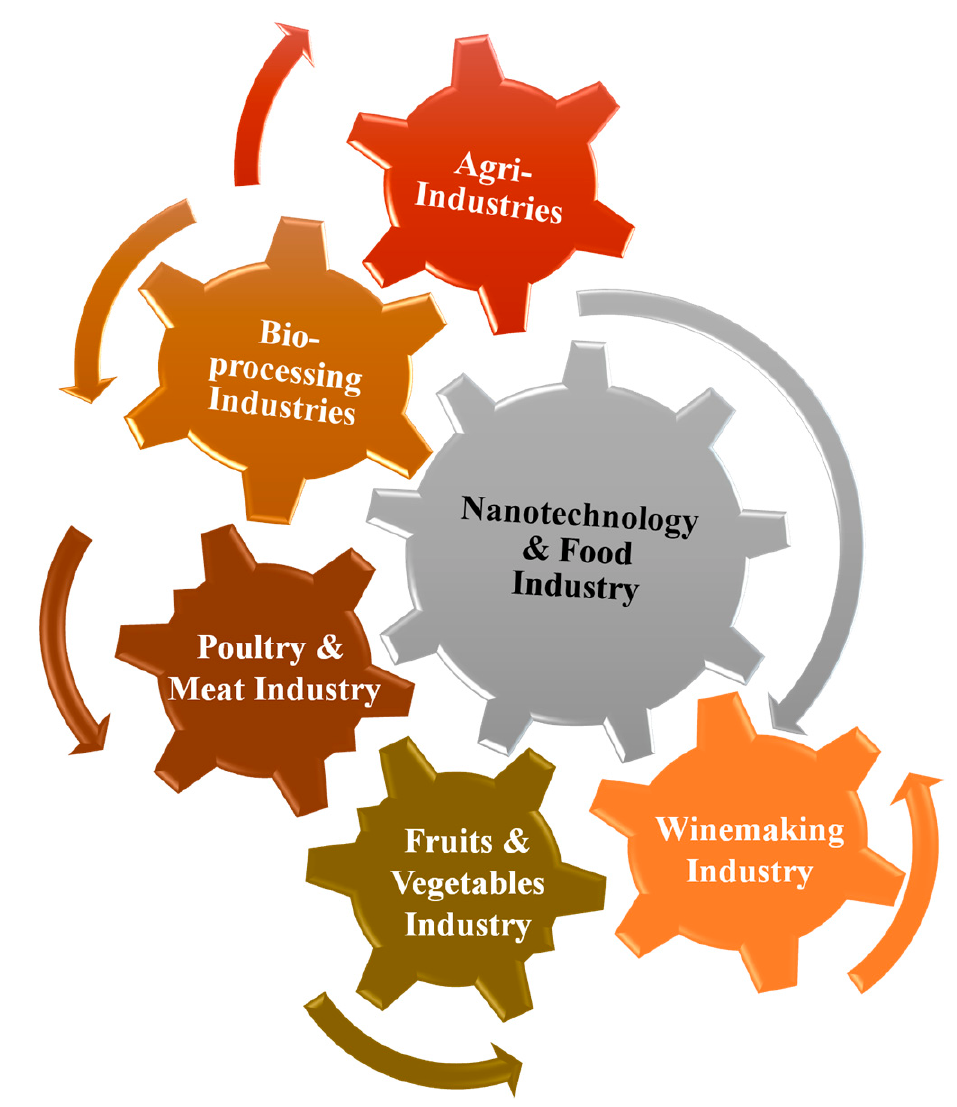
Figure 1. Nanotechnology applications in food and interconnected industries.